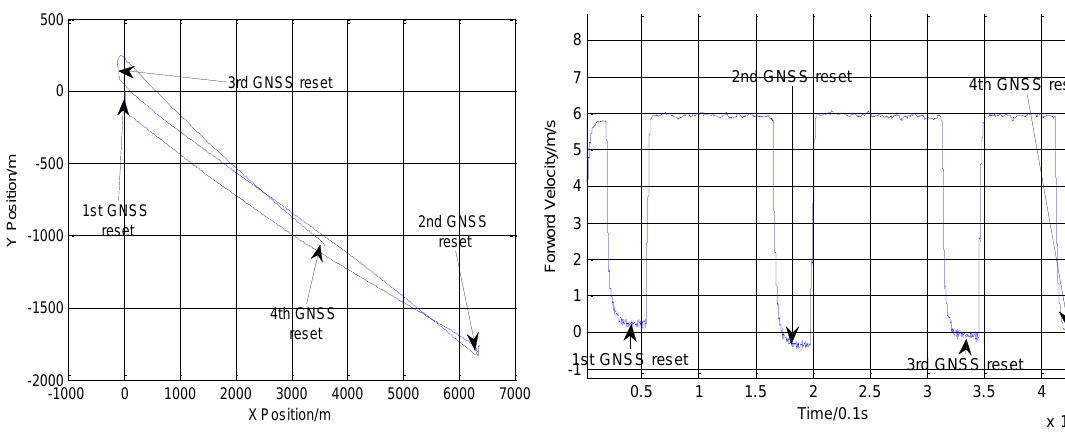
Figure 4. The trajectory and forward velocity of the vessel in the river trial.